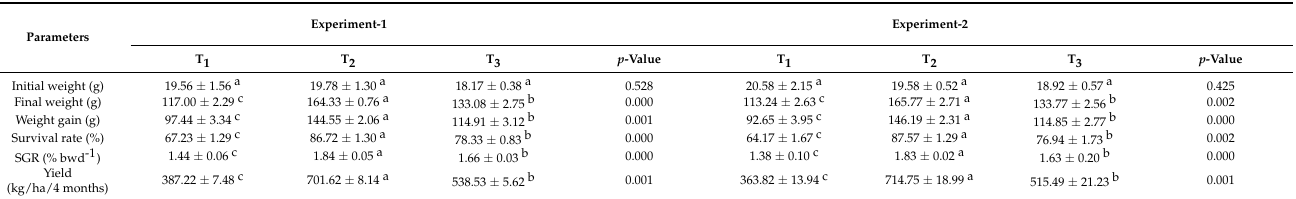
Table 5. Growth parameters and yield of fishes under rice–fish–vegetable